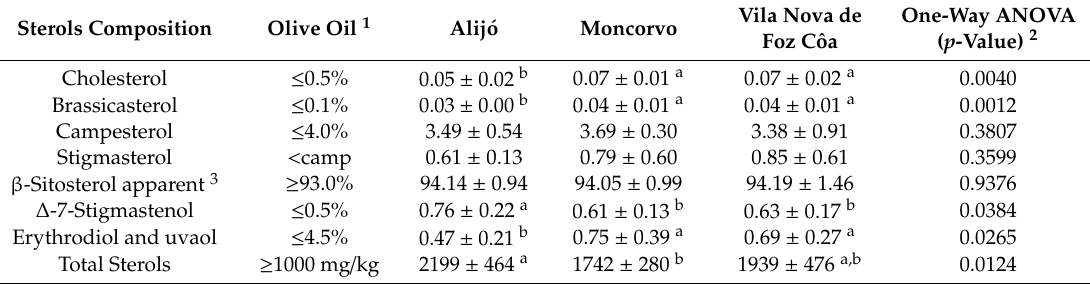
Table 4. Sterol compositions of oils extracted from oleaster (mean ± standard deviation) collected from di ff erent geographical locations (Alij ó . Moncorvo and Vila Nova de Foz C ô